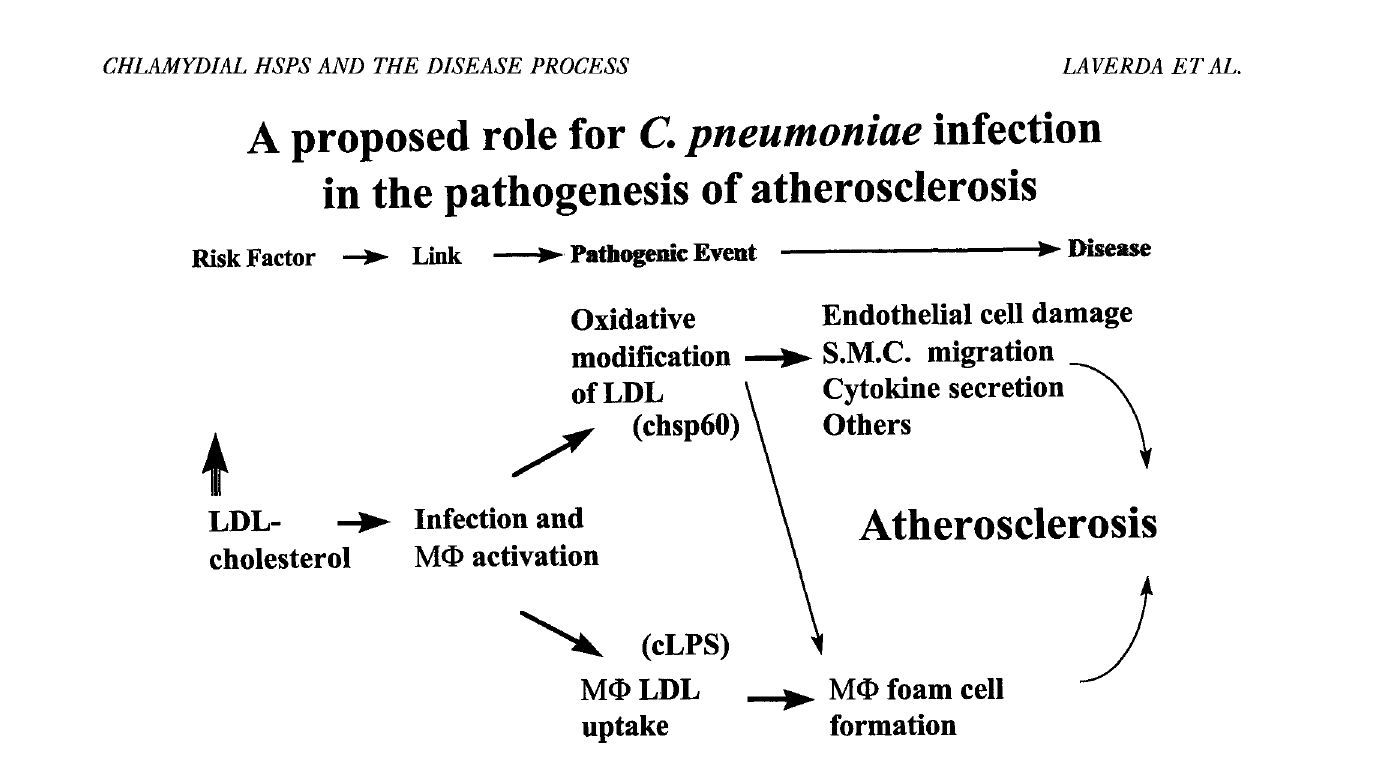
Fig. I. Chlamydia pneumoniae and atherosclerosis, Links between a known risk factor (elevated LDL), two possible chlamydial virulence factors (LPS and Hsp60), and the disease process (foam cell formation and oxidative-mediated tissue damage).